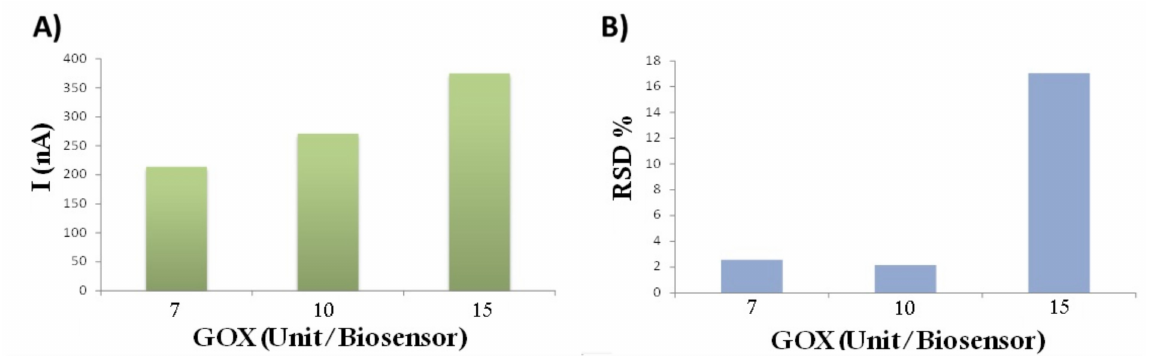
Figure 7. ( A ) Plot of current intensity versus the glucose oxidase enzyme loading (active units) per biosensor for a GOX/PANI-AuNPs(2 µ L)/SNGC electrode ( B ) Relative standard deviation (n = 3). Experimental conditions: Cyclic voltammetry; 0.1 M phosphate-buffered solution pH 6.8 containing 0.5 mM of